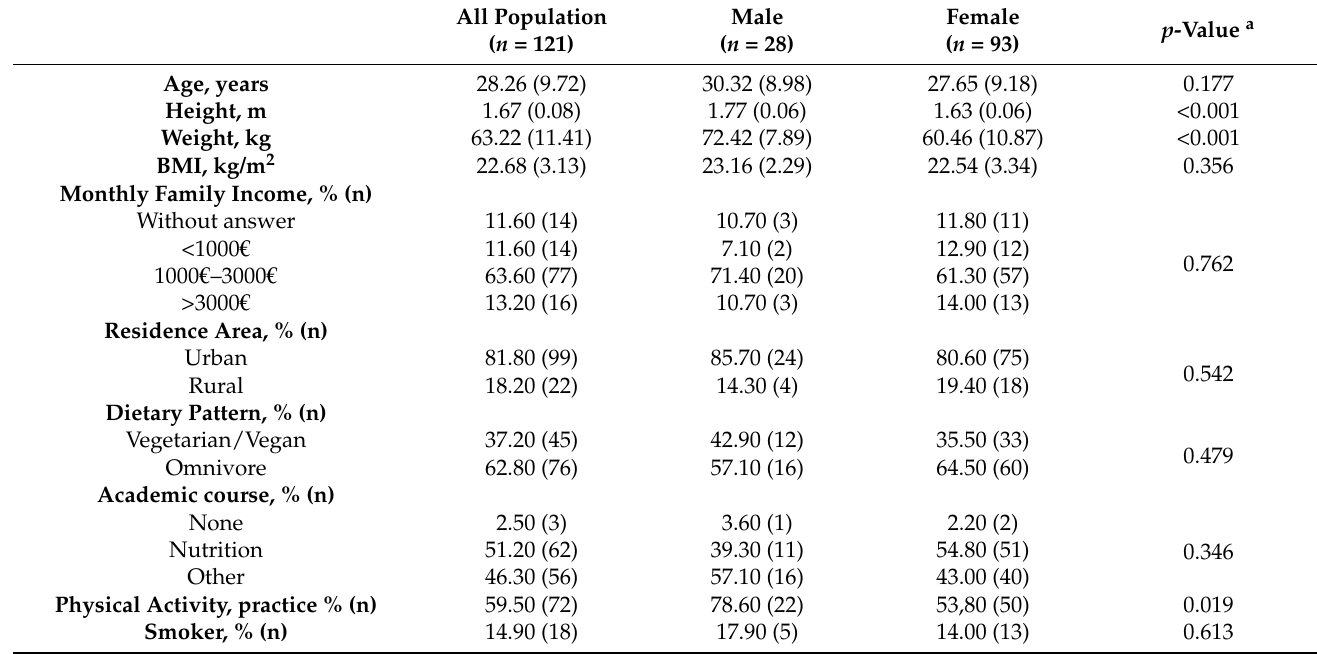
Table 1. General characteristics of the study population categorized by sex.